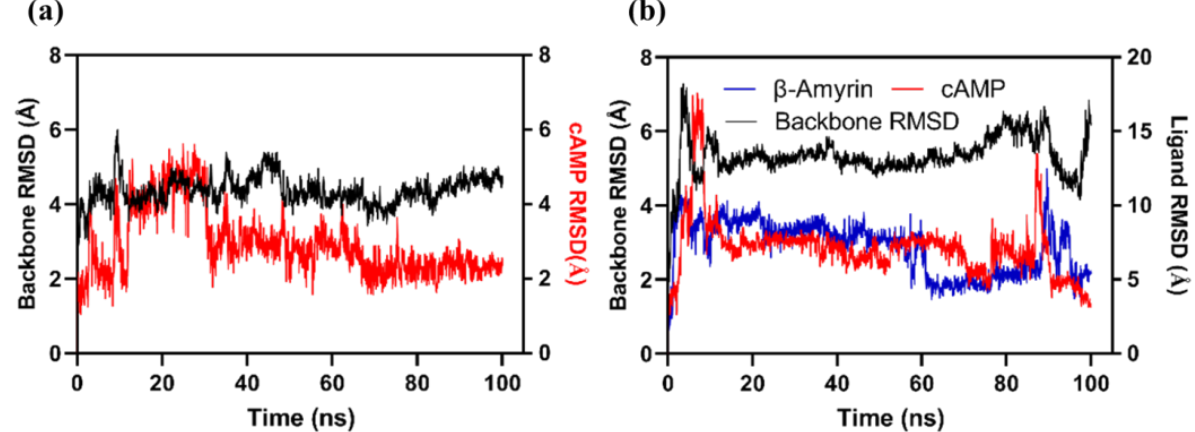
Figure 5. Molecular dynamics simulation of Rv1636-cAMP complex with and without β -Amyrin. ( a ) Evolution over time of the RMSD values of Rv1636-cAMP standalone complex. ( b ) RMSD values of the Rv1636 complex with cAMP and β -Amyrin.